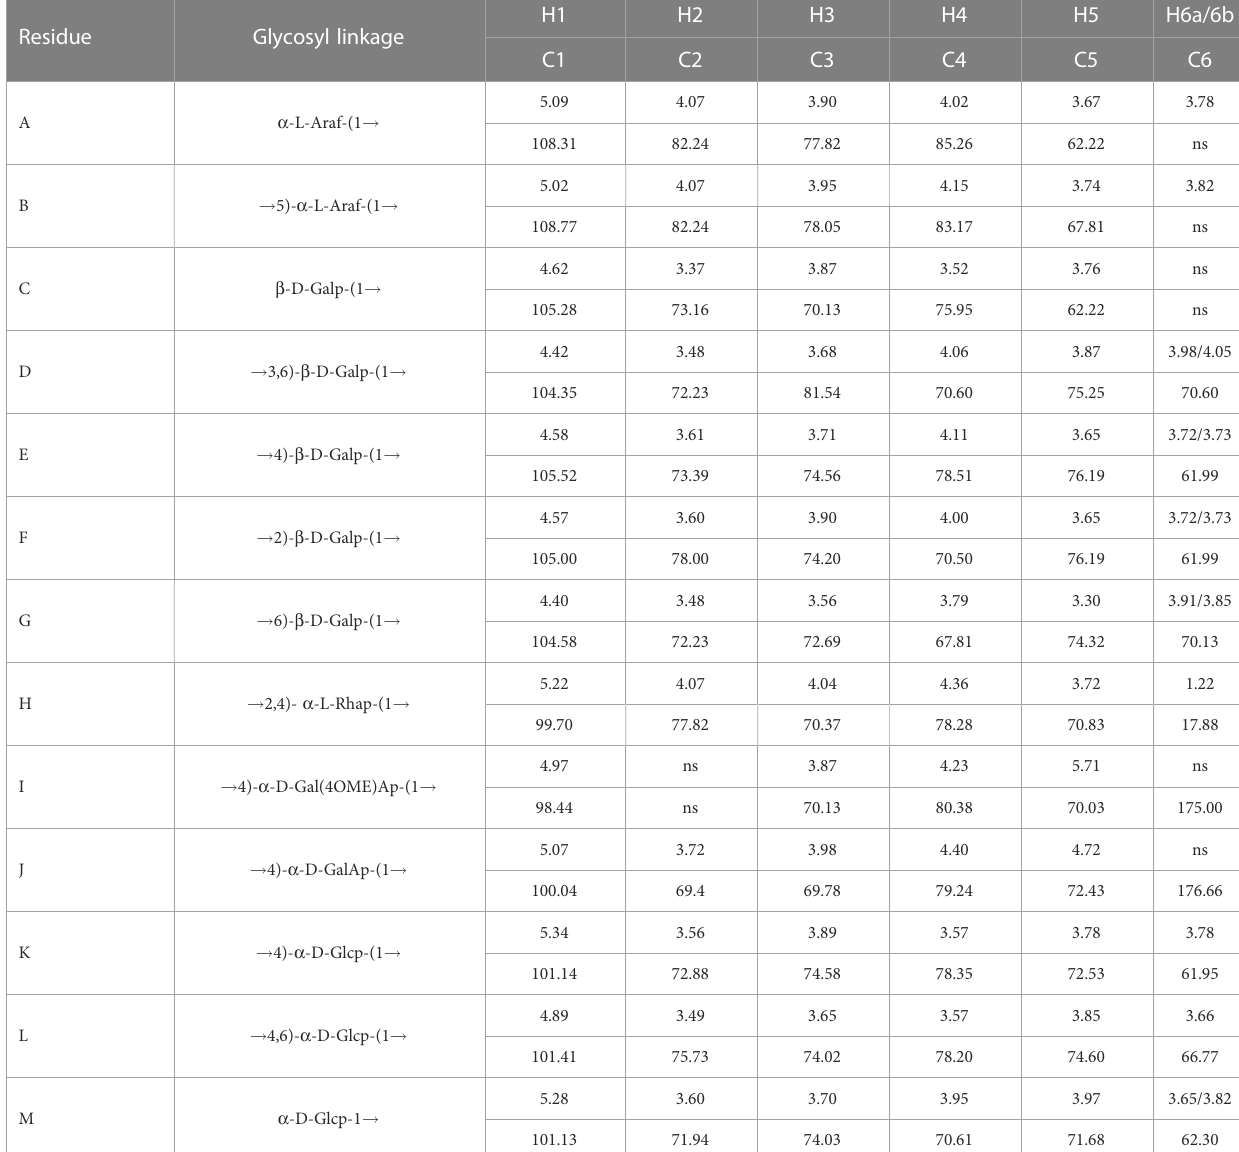
Residue Glycosyl linkage